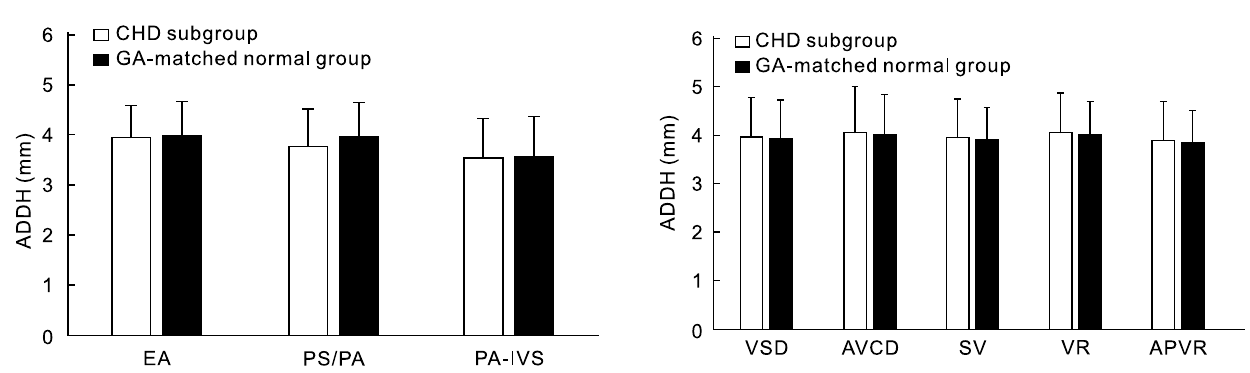
Figure 3 ADDH differences between the right-side obstruction lesions and GA-matched normal subgroups. ADDH, aortic diameter at the diaphragmatic; CHD, congenital heart disease; GA, gestation age; EA, Ebstein’s anomaly; PS/PA, pulmonary stenosis or pulmonary atresia; PA- IVS, pulmonary atresia with intact ventricular srptum.